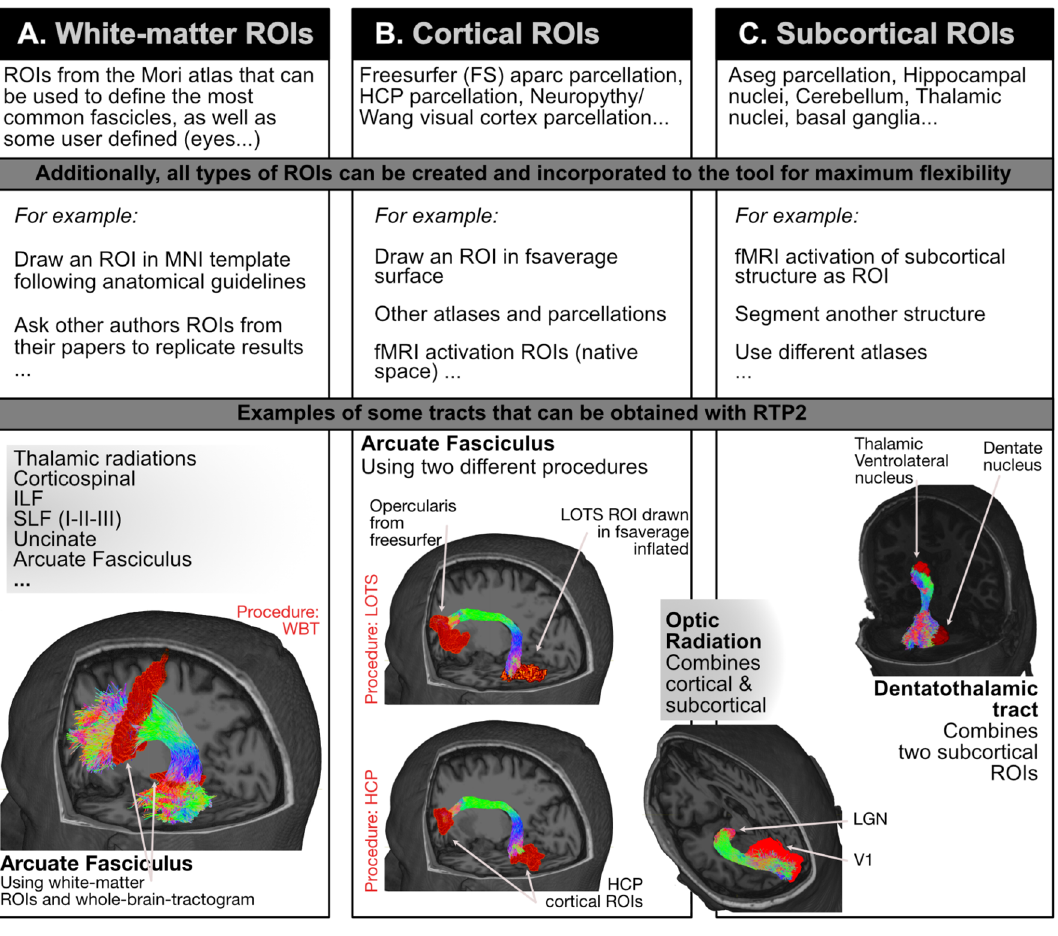
Figure 2. RTP2 Flexibility: any combination of ROIs and several diffusion models can be used to measure tracts of interest. The RTP2 tool allows for an almost infinite combination of ROIs to obtain tracts. These ROIs can be classical anatomically defined white-matter tracts (see examples in first row), which can be used to track in any combination: ( A ) ROIs are used to select fibers from a whole-brain tractogram, ( B ) ROIs are cortical structures, and ( C ) subcortical ROIs. Additionally, the system is prepared to input user defined ROIs without any coding (see examples in second row). We include some example tracts that can be obtained from the pre- installed ROIs to illustrate how RTP2 tracking works, but the system is fully configurable by the researcher. In red examples for the three procedures used to illustrate the reproducibility analysis. WBT: Whole-brain tractography, HCP: Human connectome project, LOTS: Lateral occipito-temporal